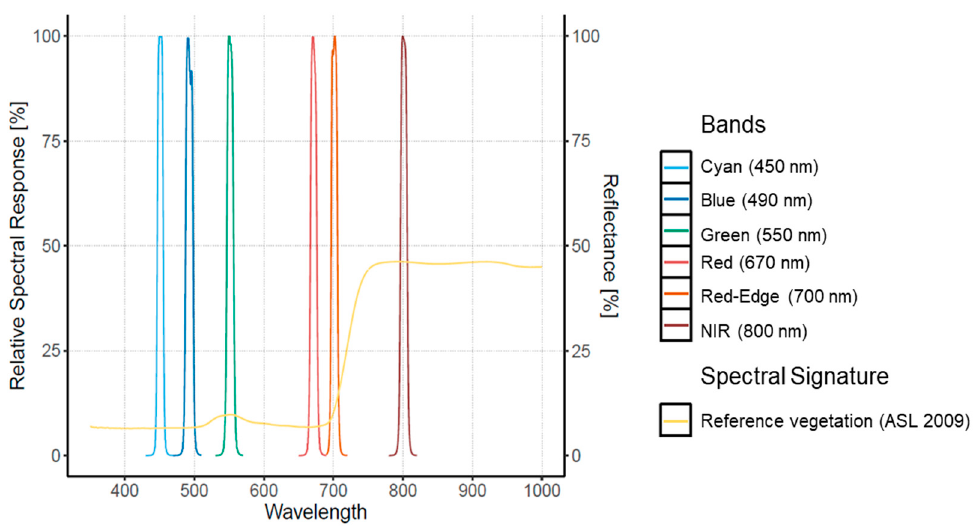
Figure 2. Relative Spectral Response for the Tetracam Macaw multispectral camera. An example of the spectral signature for pine vegetation trees derived from Aster Spectral Library (ASL 2009) is included from Baldridge et al. (2009).